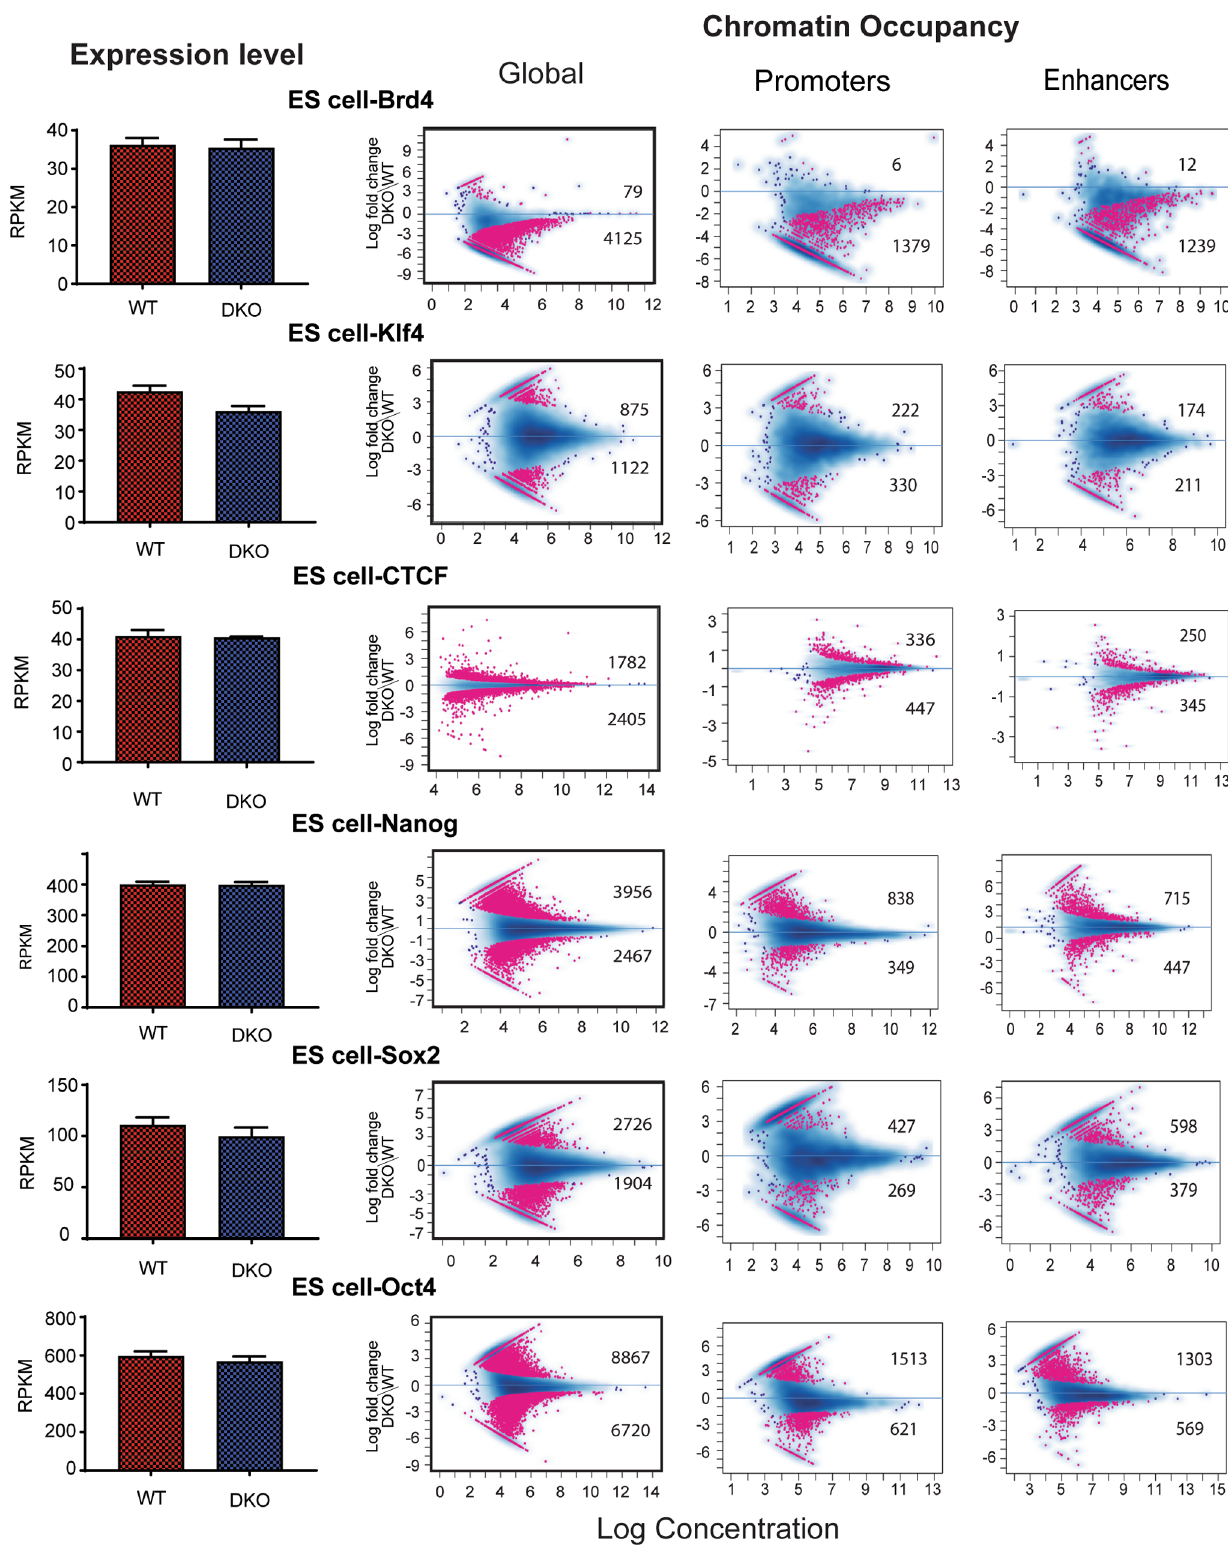
Fig. 6 Altered chromatin occupancy of transcription factors in DKO ESCs cells. Bar graphs on left show transcript levels determined by RNA seq analysis. MA plots show differences in TF chromatin binding between DKO and WT cells. Sites showing signi fi cant differences (FDR < 0.05) are in red; the number of up- and downregulated sites are indicated in each panel. Blue dots and blue density cloud represent all points corresponding to the non-changing regions. All data from 2 biological